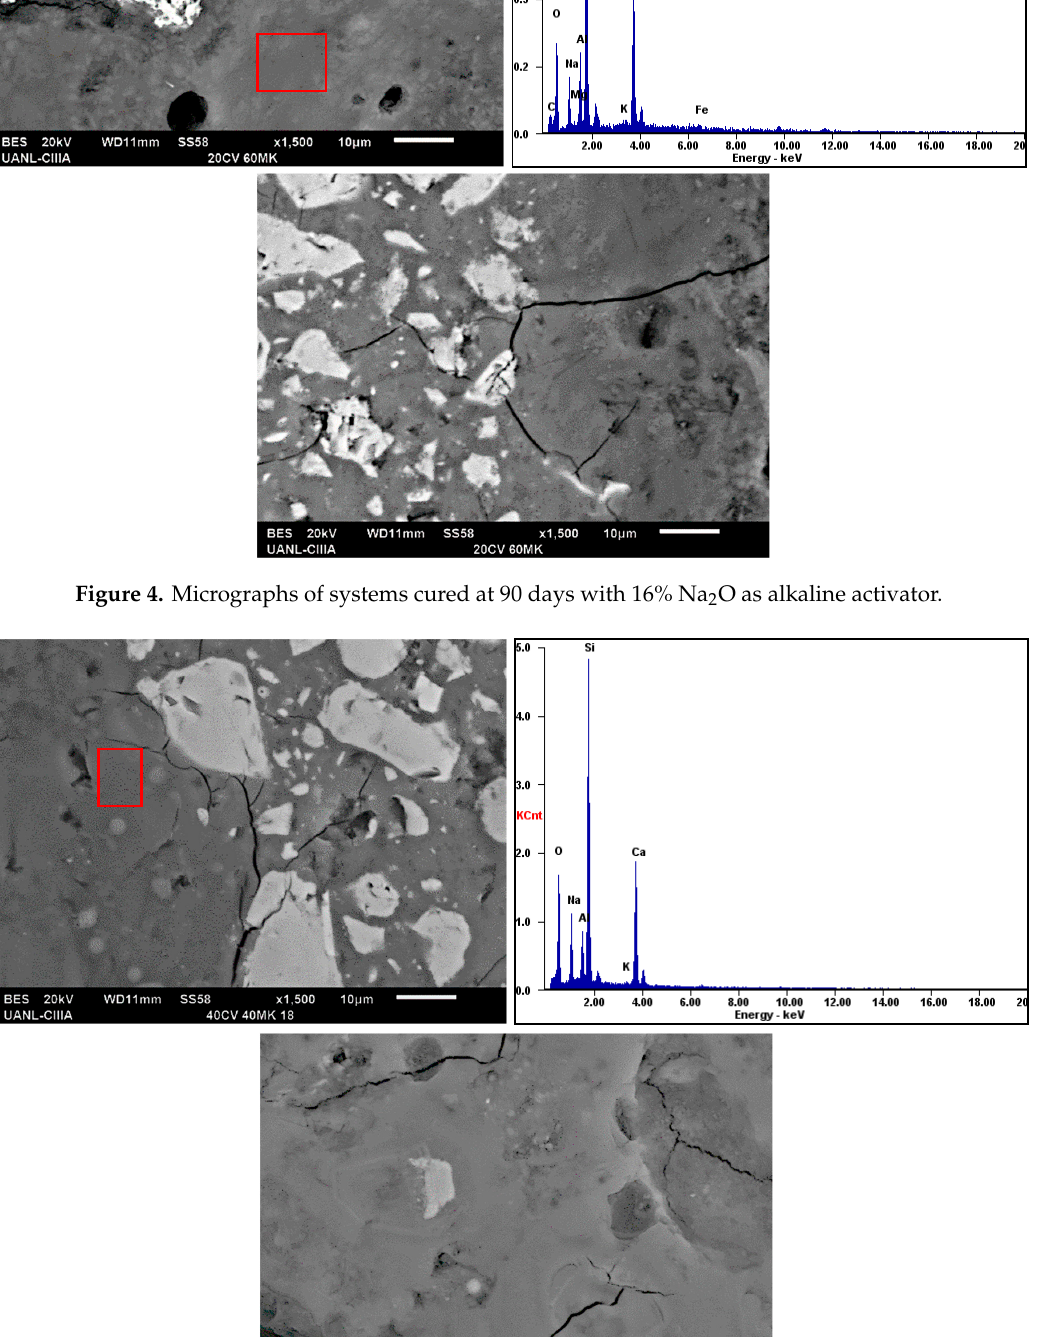
2 O as alkaline